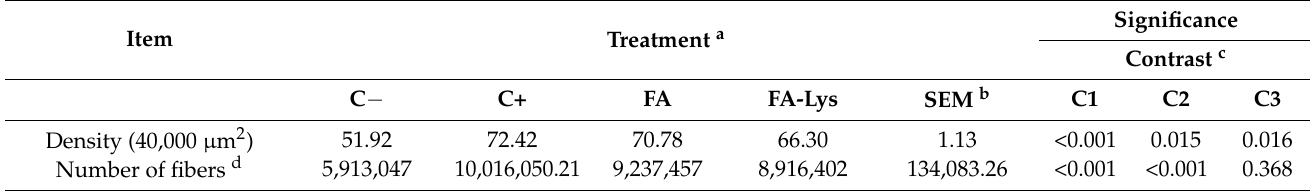
Table 4. Muscle fiber density and total number of fibers from LM area of finishing pigs with FA or ractopamine (alkaline ATPase staining).